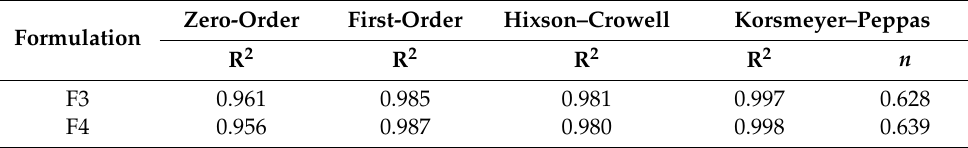
Table 7. Mathematical models for drug release kinetics of F3 and